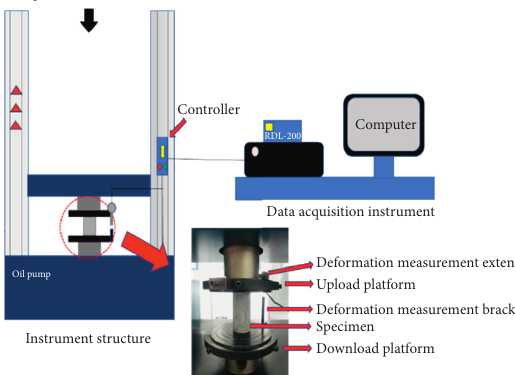
Figure 4: Uniaxial creep load test